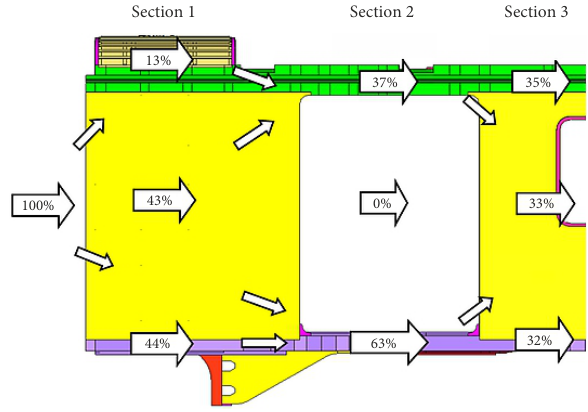
Figure 14. Transfer path distribution of the collision